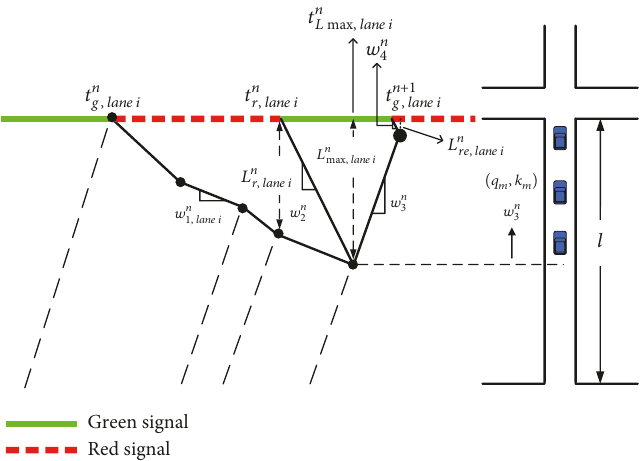
Figure 5: Queue length discharging